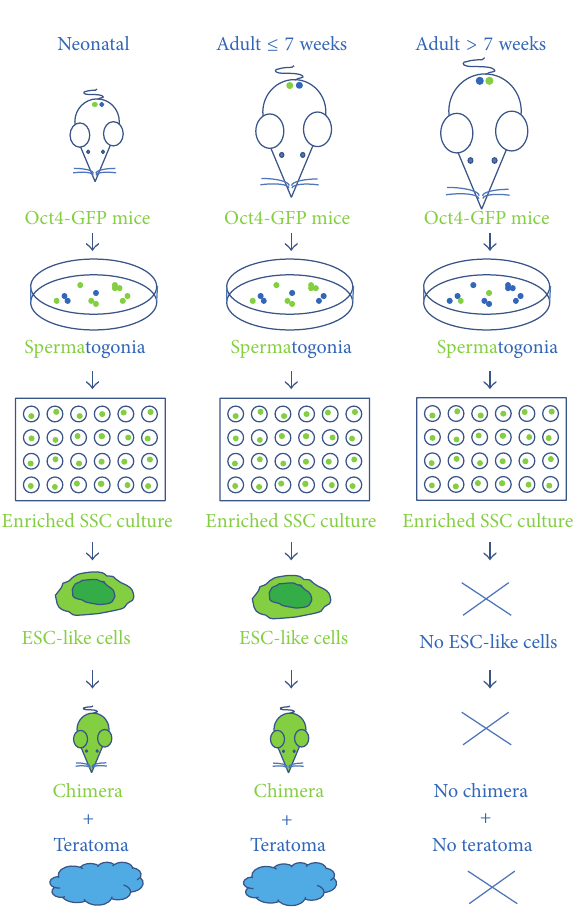
Figure 6: Schematic illustration pinpoints that occurrence of pluripotent ESC like cells from Oct4 GFP positive cells with the production of chimera and formation of teratoma is restricted to neonatal up to 7-week-old